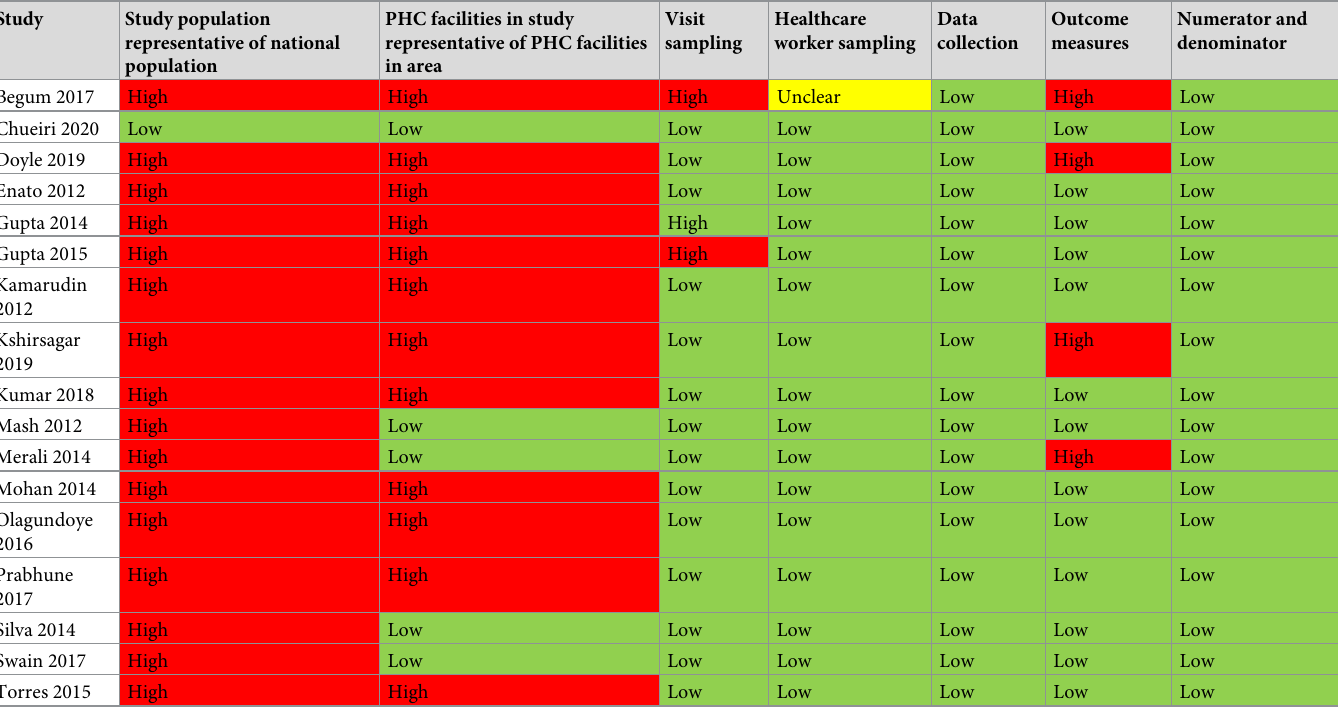
Table 2. Quality assessment of included studies.